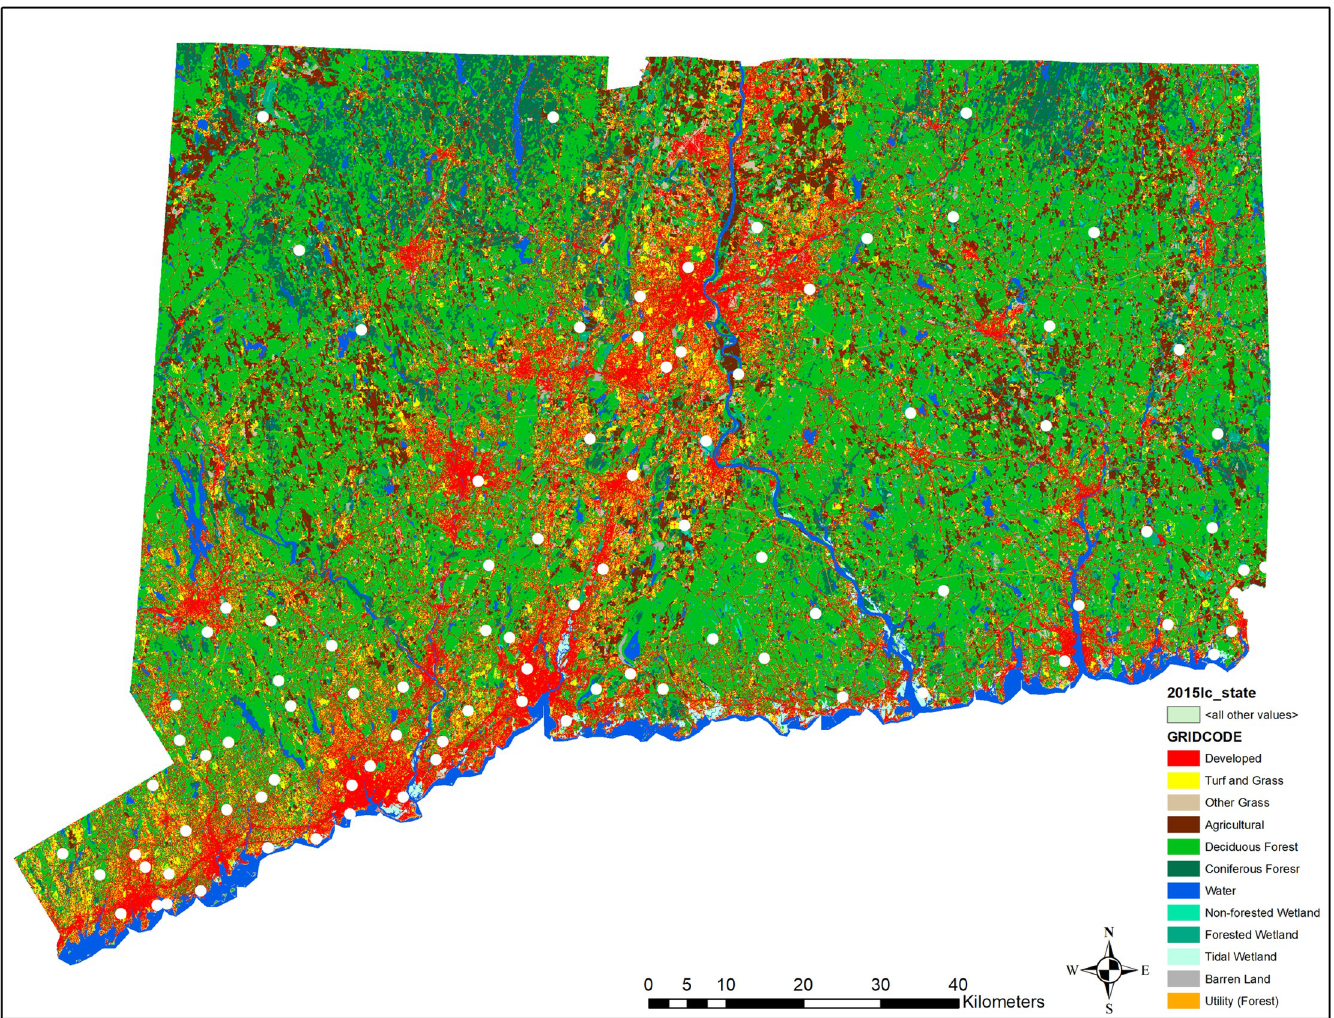
Fig 1. Map of Connecticut 2015 land cover and the Connecticut Agricultural Experiment Station’s mosquito and arbovirus surveillance locations (shown as white circles). Land cover data to create this map were obtained from the University of Connecticut, Center for Land Use Education and Research (CLEAR) (https://clear. uconn.edu/projects/landscape/download.htm#top). The map was created using ArcMap V 10.5.1 (ESRI, Redlands, California, U.S.).